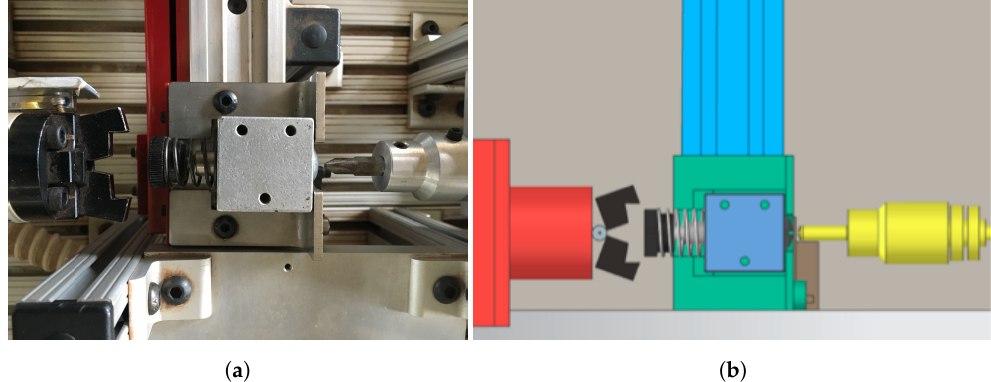
Figure 12. ( a ) machine, initial position; ( b ) virtual model, initial position.